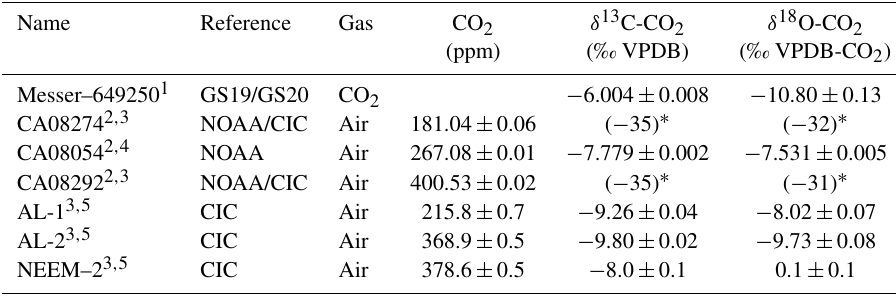
Table 2. CIC reference standards for CO 2 mixing and stable isotope